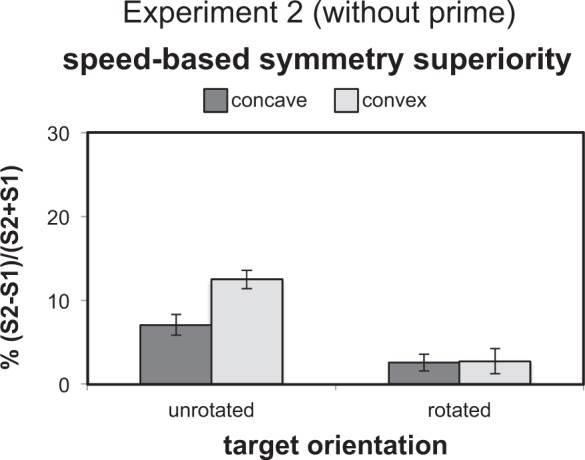
Experiment 2. Mean values (± 1 sem) of speed-based symmetry
superiority in the reduced Rotation × CCP design.